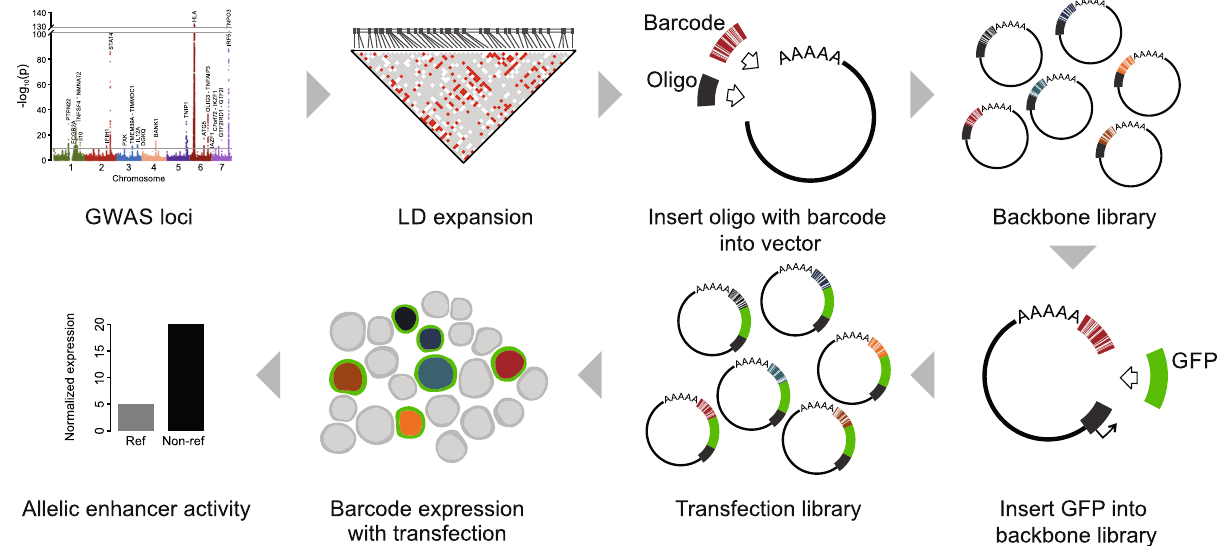
Fig. 1 Massively parallel reporter assay work fl ow. Schematic of study design. Representative Manhattan plot of SLE-associated risk loci reproduced from ref. 78